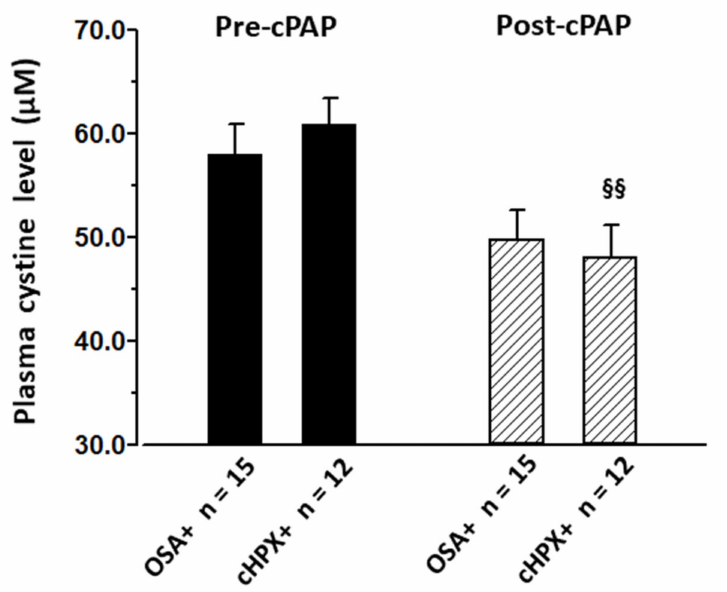
Figure 4. Plasma cystine (CySS) plasma levels before and after 3–5 months CPAP therapy in OSA patients (AHI > 15 h − 1 ) as well as in the explorative cHPX group (Tu90% > 15.2 min) (see “Methods” section “statistics”). Data are presented as mean ( ± SEM); §§ for p < 0.01 by t -test for paired observations (post- vs. pre-CPAP